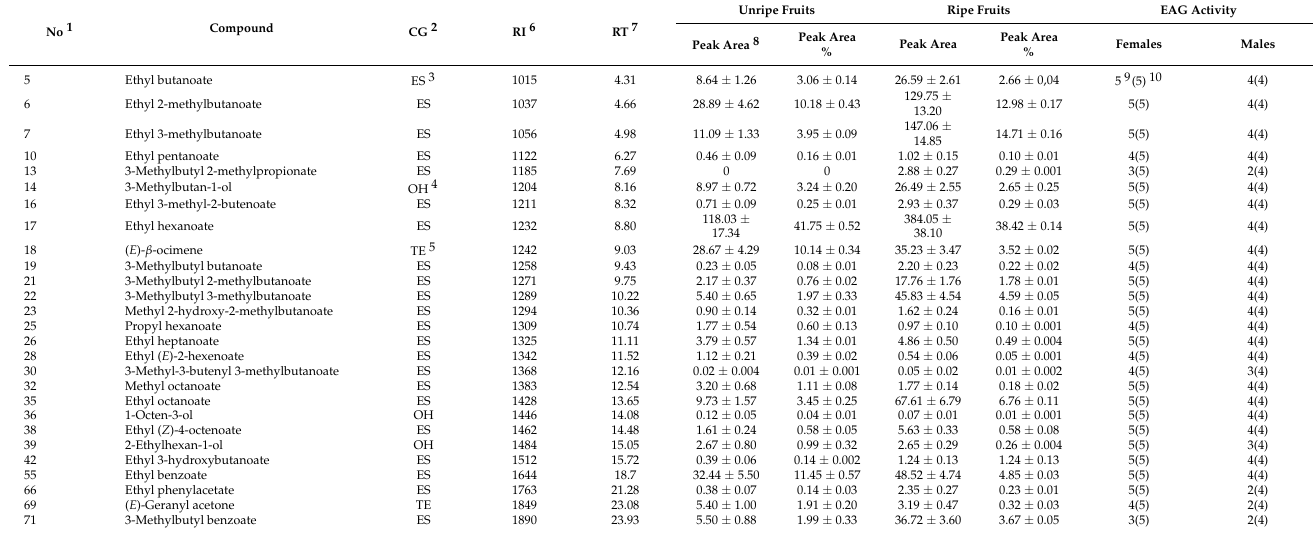
Table 2. EAD active volatiles identified in headspace of sea buckthorn Hippophae rhamnoides fruits at two ripening stages (unripe fruits and ripe fruits) and their electroantennographic activity to fruit flies Rhagoletis batava